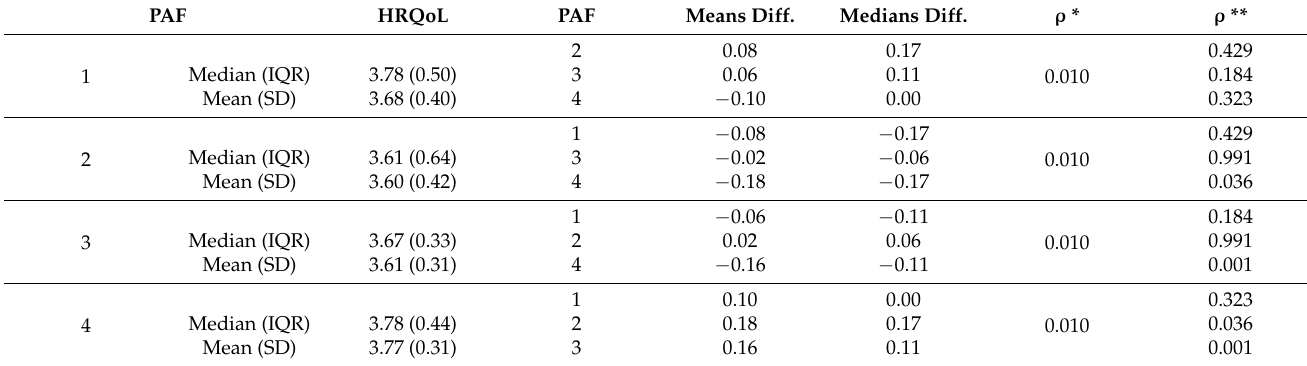
Table 2. Health-related quality of life comparison with physical activity frequency in spanish children and adolescents with